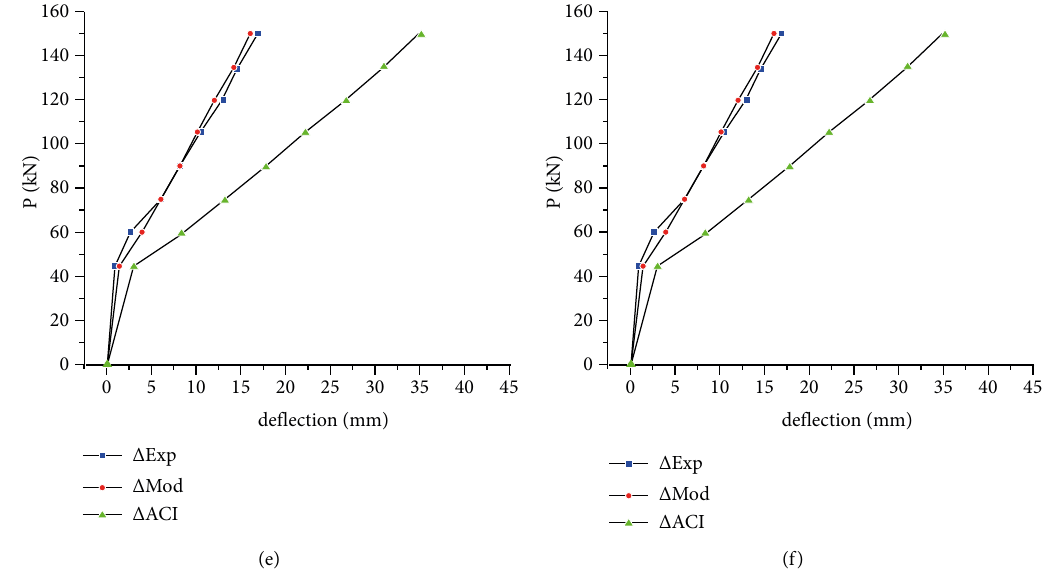
Figure 11: Comparison of deflection results. (a) B2. (b) B3. (c) B4. (d) B5. (e) B6. (f)